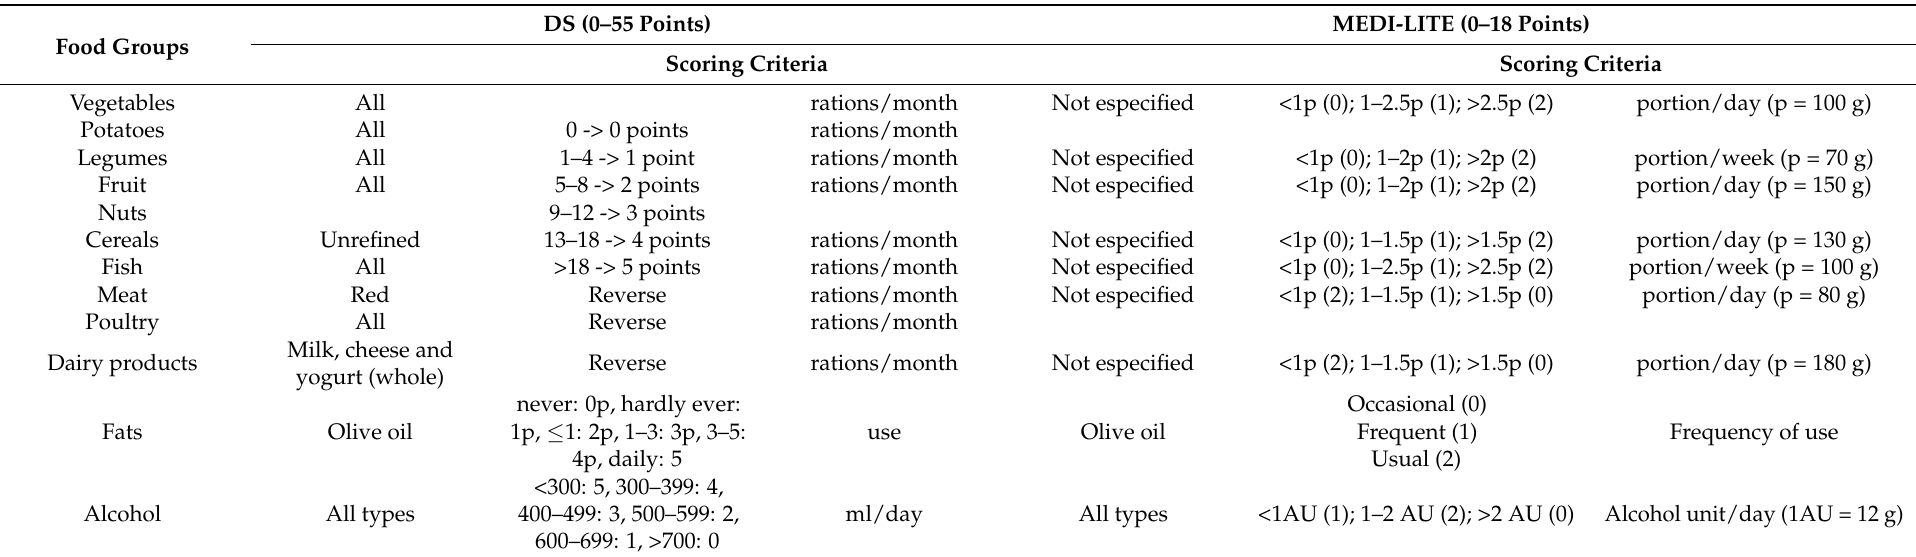
Table 3. Characteristics of the different adherence indexes to the Mediterranean